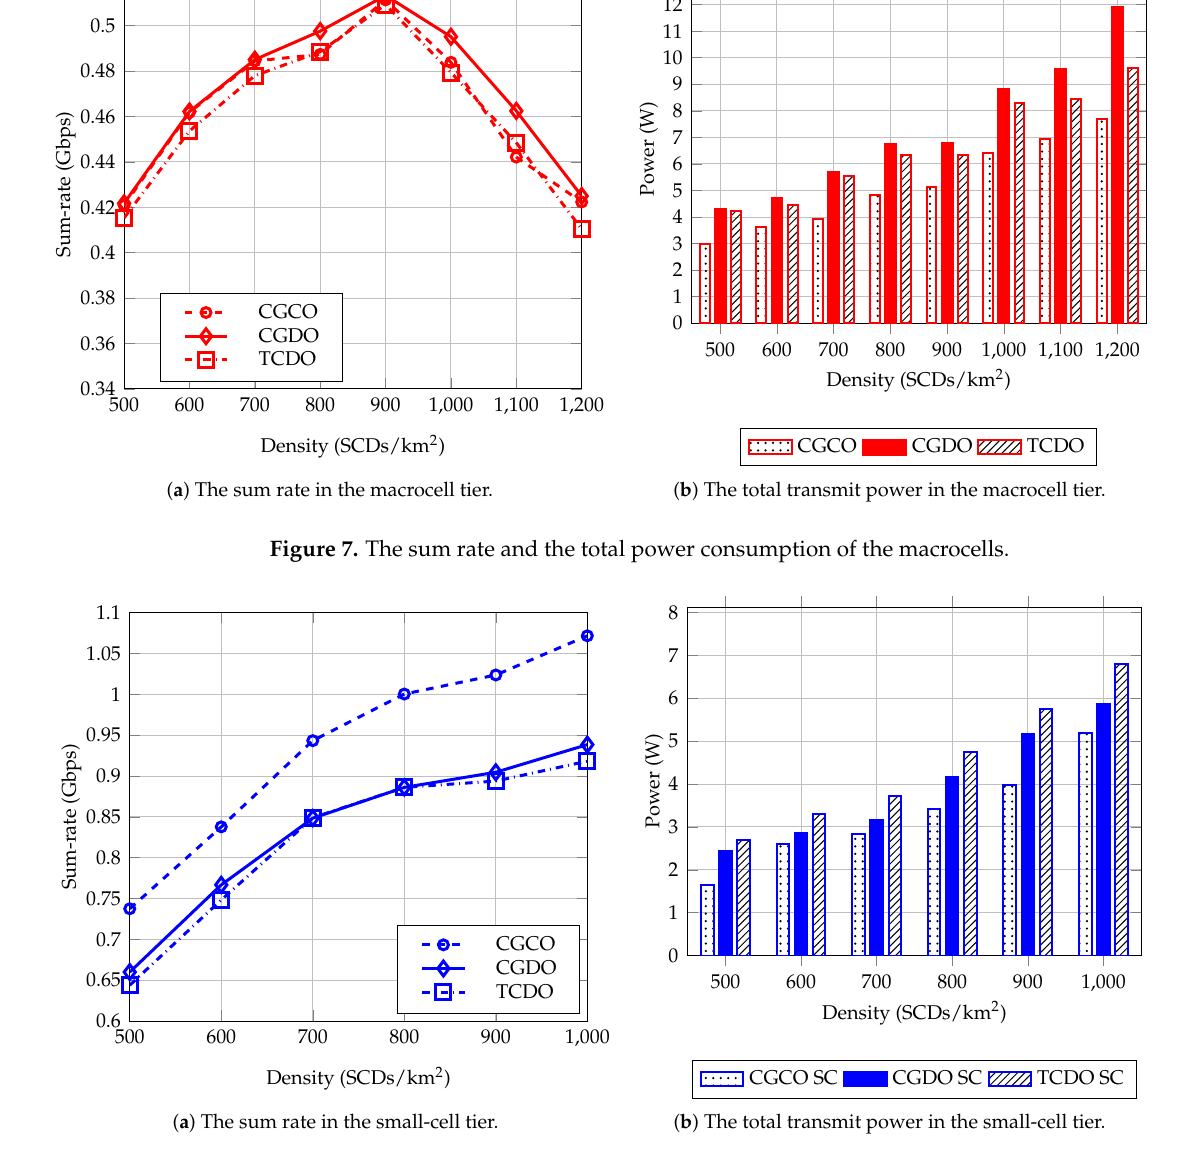
Figure 8. The sum rate and the total power consumption of the small